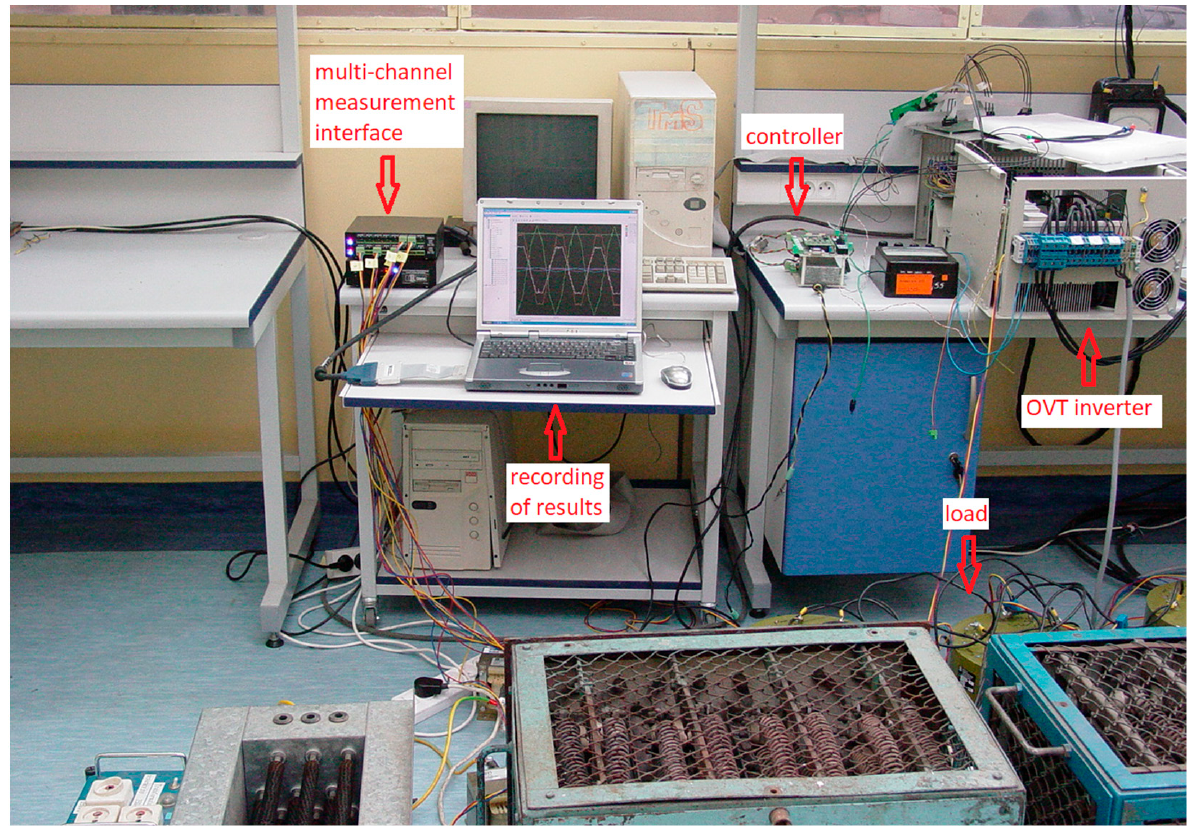
Figure 9. The appearance of the experimental station.